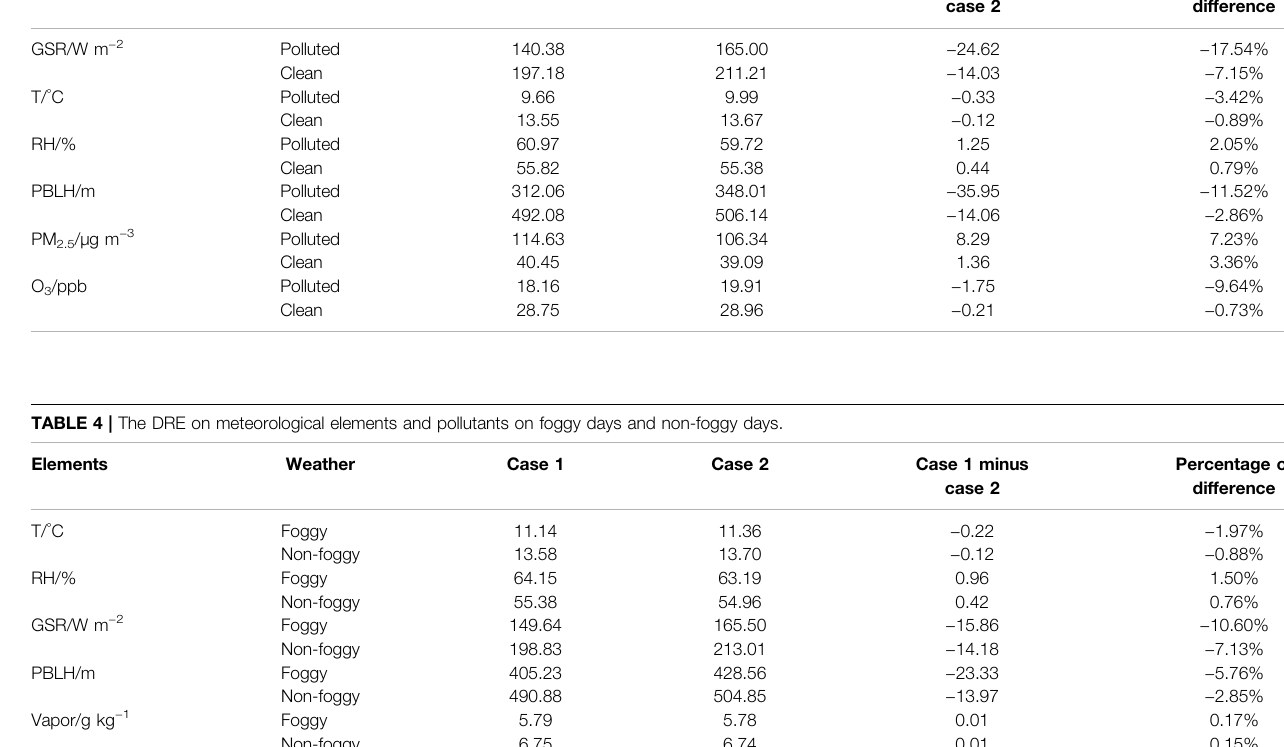
TABLE 3 | The DRE on meteorological elements and pollutants on polluted days and clean days. Elements